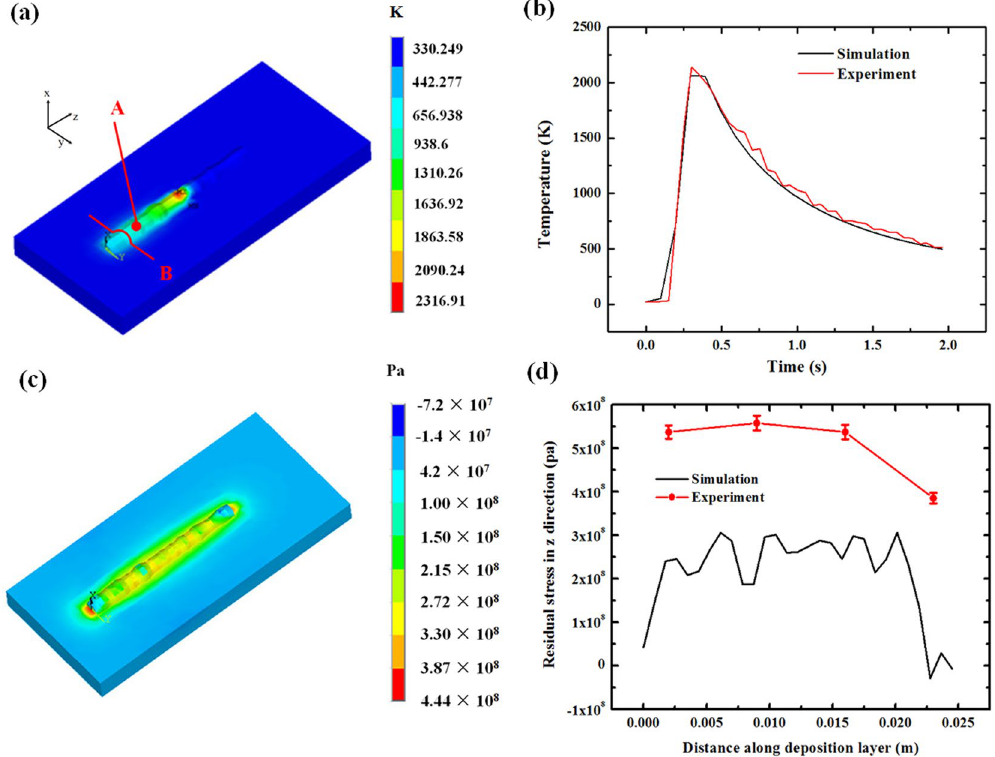
Figure 6. Temperature field simulated by thermal FEM method. ( a ) Temperature distribution at half of the process, ( b ) Time history of temperature at point A, ( c ) the z direction stress distribution, ( d ) The residual stress along the top surface of the sample.